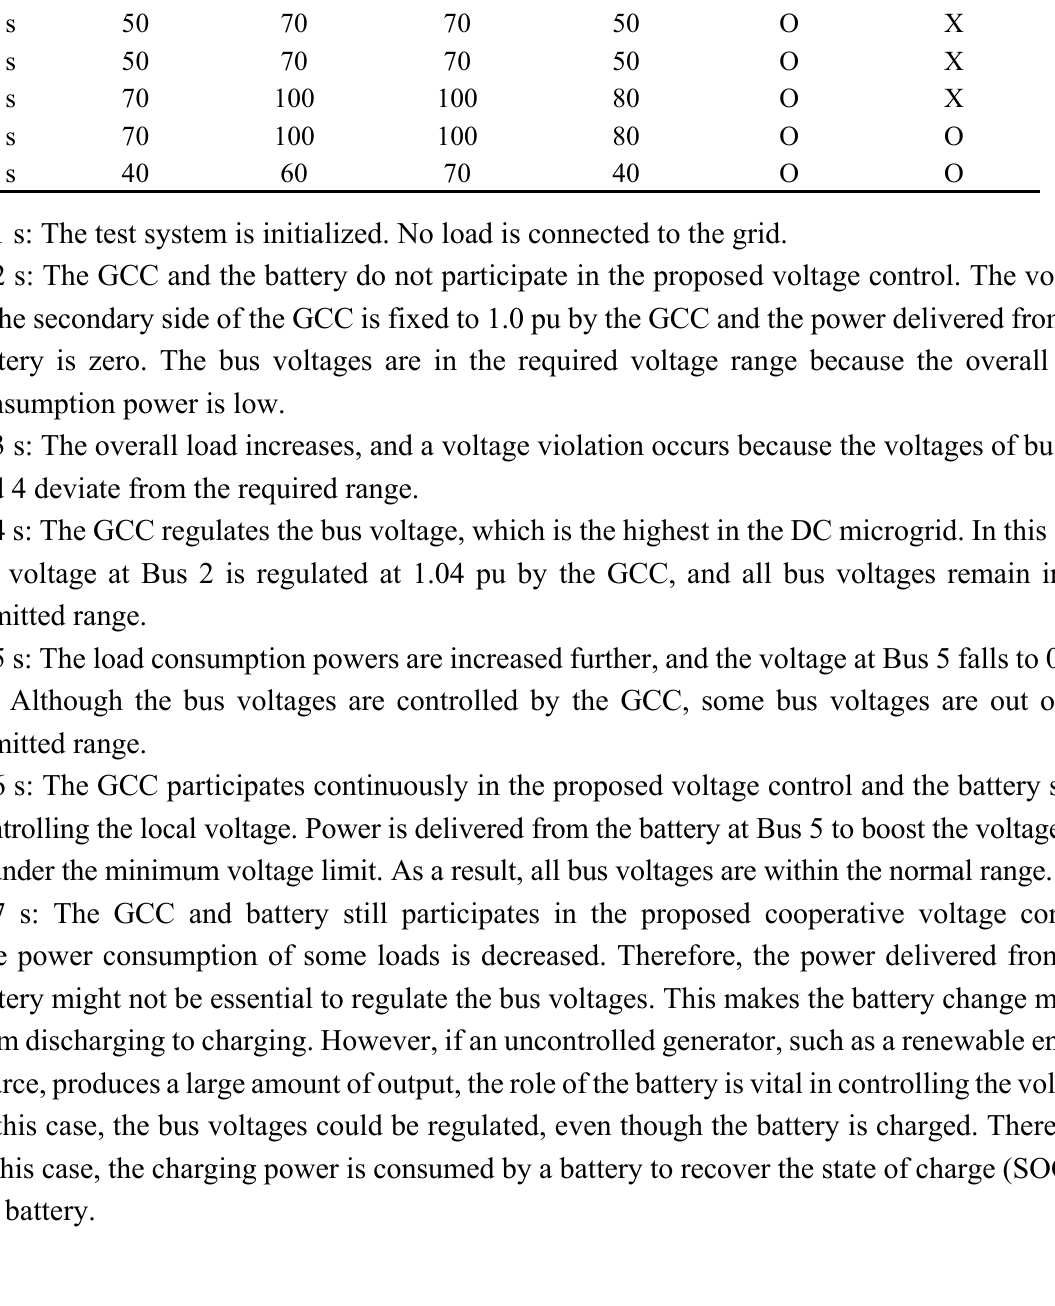
Table 5. Simulation scenario for the cooperative voltage control method. Load Power (kW) Voltage Control Time Bus 2 Bus 3 Bus 4 Bus 5 GCC Battery 0 s --------------- Initializing --------------- 1 s 10 20 20 10 X X 2 s 50 70 70 50 O X 3 s 50 70 70 50 O X 4 s 70 100 100 80 O X 5 s 70 100 100 80 O O 6 s 40 60 70 40 O